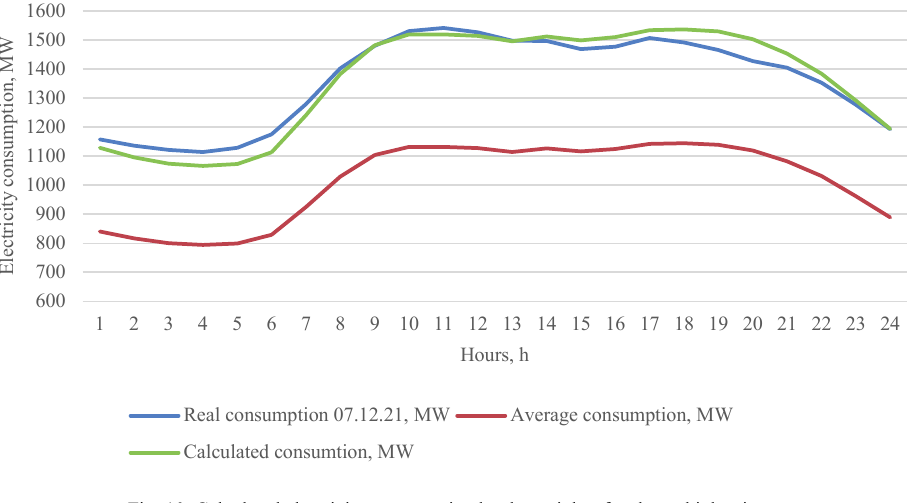
Fig. 10. Calculated electricity consumption by the weight of an hour, high price.